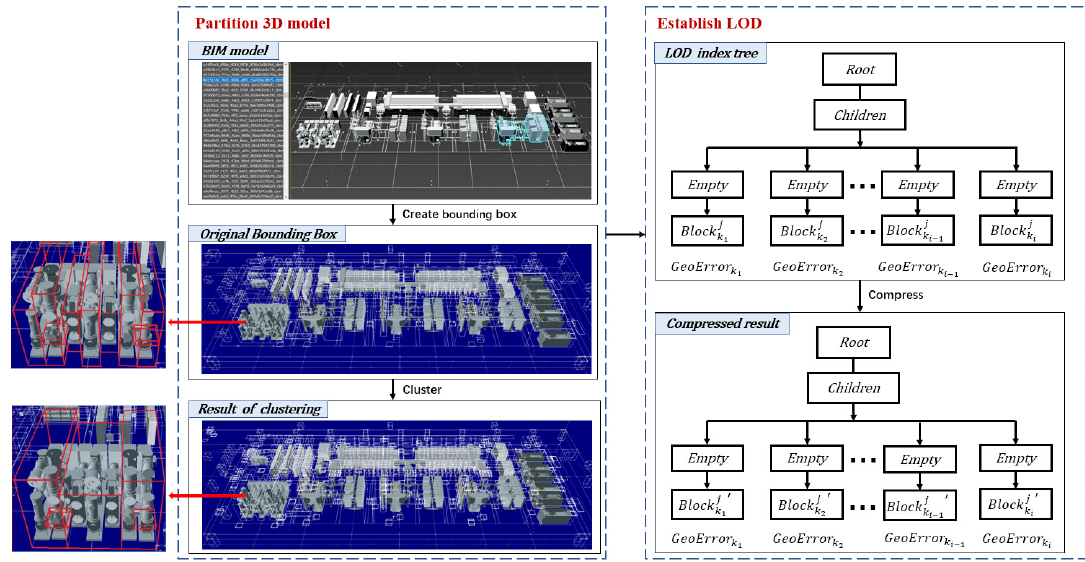
Figure 4. Overall process for data organization of the BIM model.